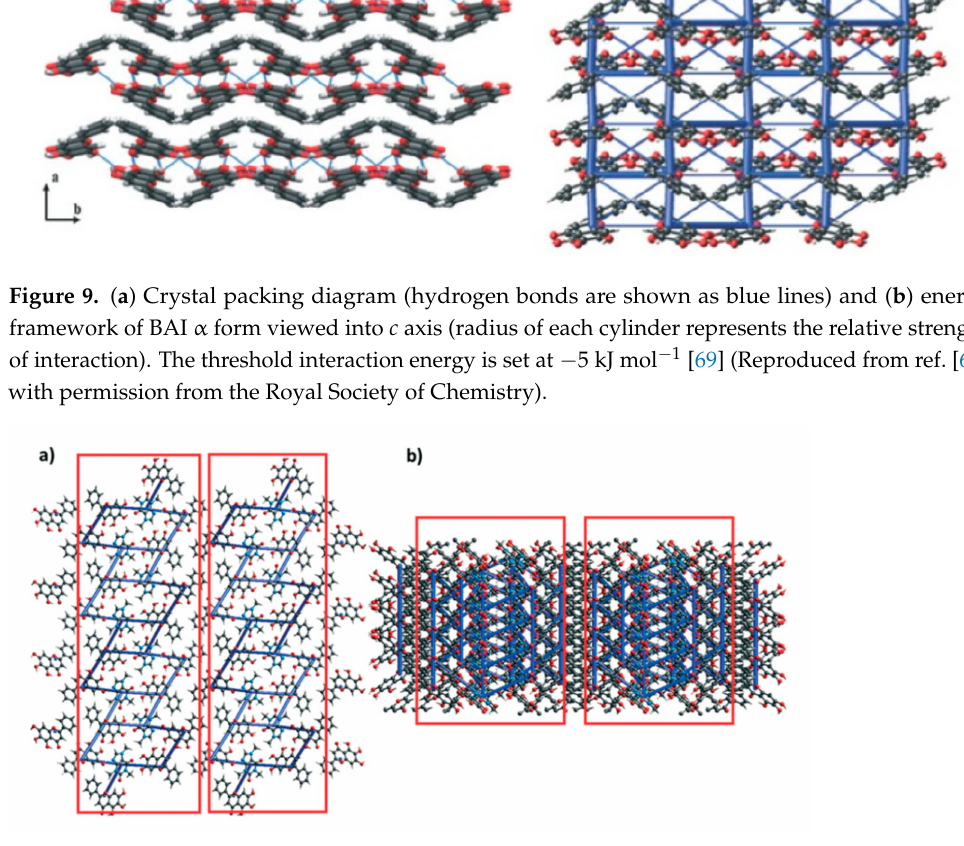
Figure 10. Energy framework of BAI–CAF viewed along ( a ) b axis and ( b ) c axis. The layers are boxed. The threshold interaction energy is set at − 20 kJ mol − 1 [69] (Reproduced from ref. [69] with permission from the Royal Society of